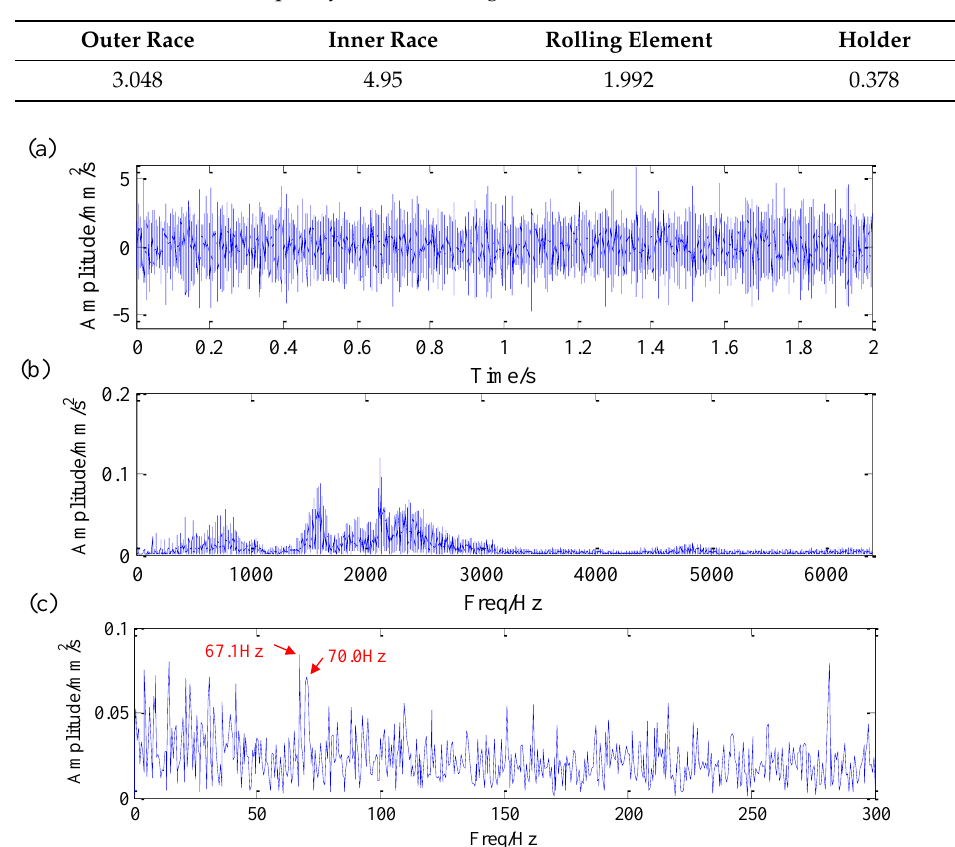
Table 1. Characteristic frequency of fault bearing.